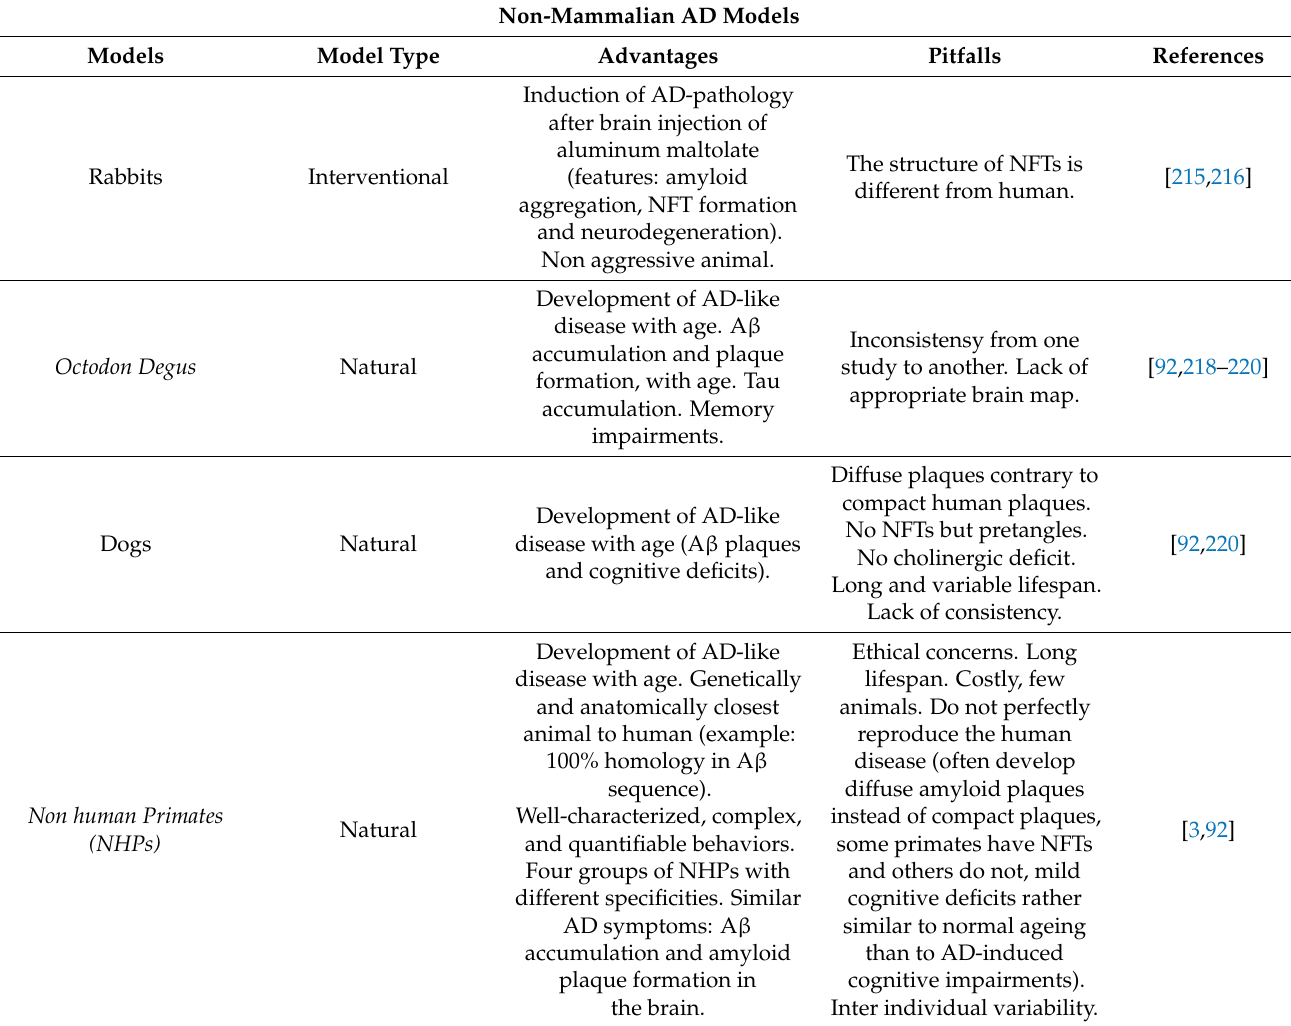
Table 7. In vivo AD models in some mammal